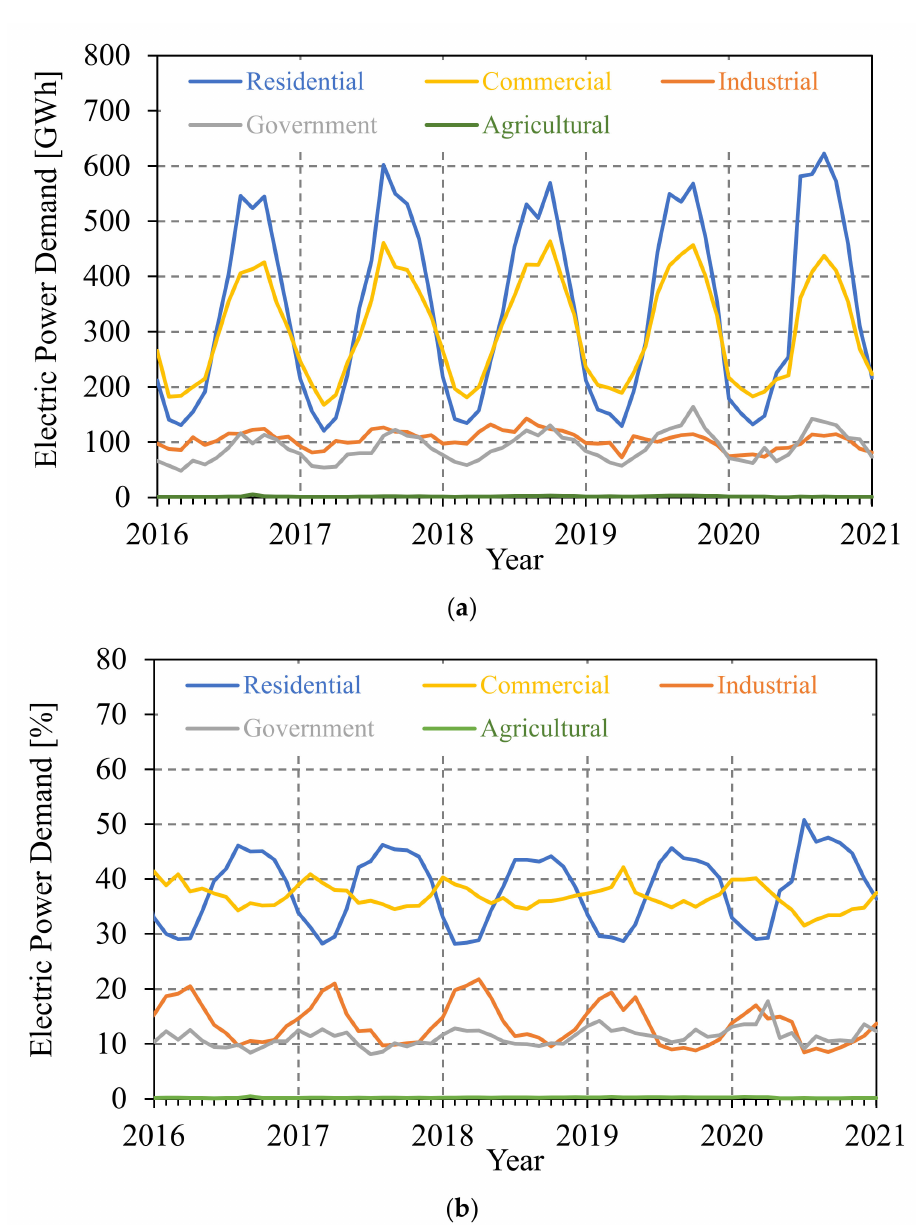
Figure 6. Monthly breakdown of the electric power demand per sector for 5 consecutive years from ( a ) a billable and ( b ) a percentage analysis relative to the total demand at a given